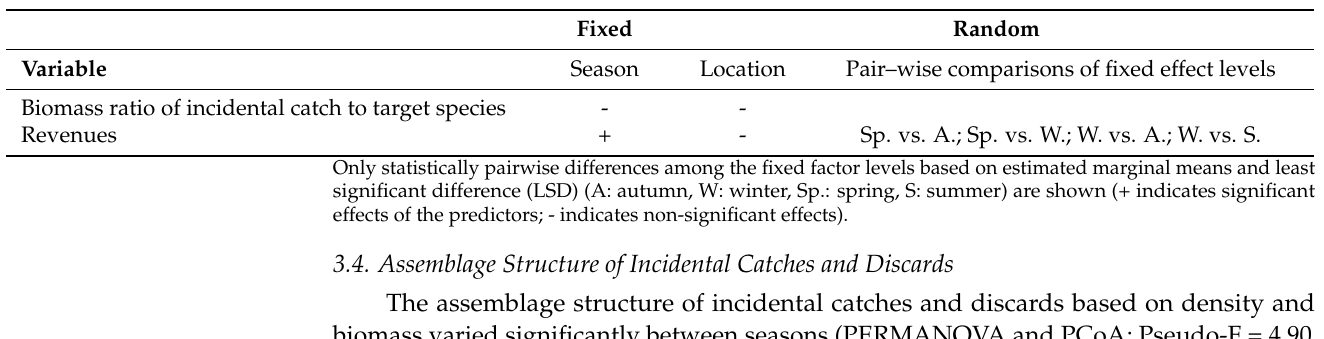
Table 6. Summary of Linear Mixed Model for the biomass ratio between incidental catch and target species, and revenues from incidental catch, with season (fixed factor) and location (random factor) as predictors.